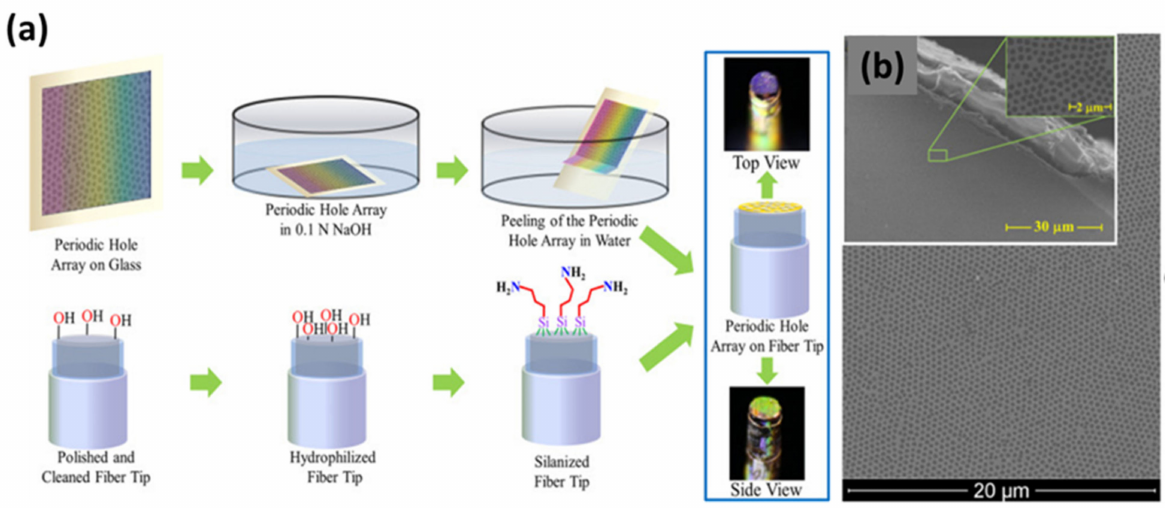
Figure 5. ( a ) Schematic of process used to fabricate fiber optic plasmonic sensor. A periodic holes array in an Au film is fabricated on a flat glass substrate using chemical methods. Subsequently, the holes array is lifted off from the substrate surface by immersing it in basic solution. The holes array film detaches from the substrate surface and starts floating on the water surface. The periodic holes array in an Au film can be picked up with an appropriately functionalized optical fiber tip. Photographs of the resulting fiber optic plasmonic sensors are shown on the right-hand side. ( b ) SEM images of a periodic hole array in a gold film on a fiber tip. Reprinted with permission from Ref. [36]. Copyright 2019